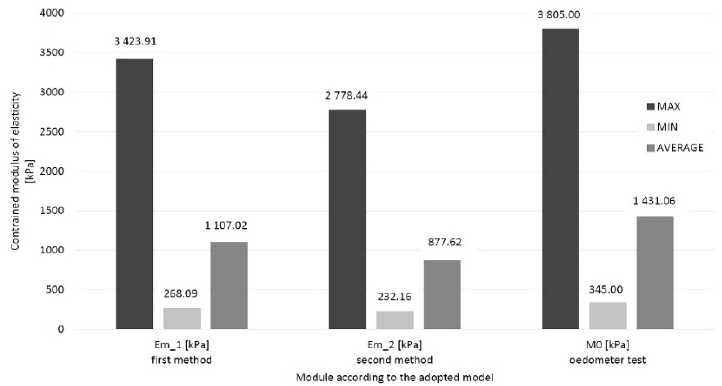
Figure 21. The minimum, maximum and average values for both methods and the results of the oedometric tests for the full-scale experiment on the Brdowski Island in Szczecin (Poland).